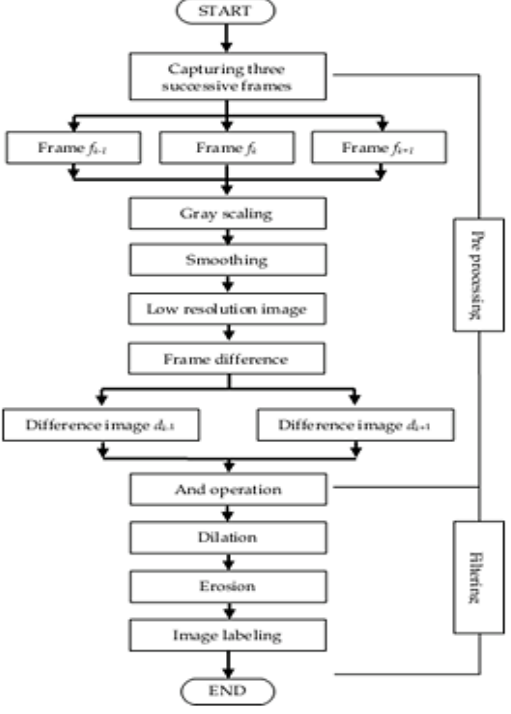
Figure 6. Flow of object detection